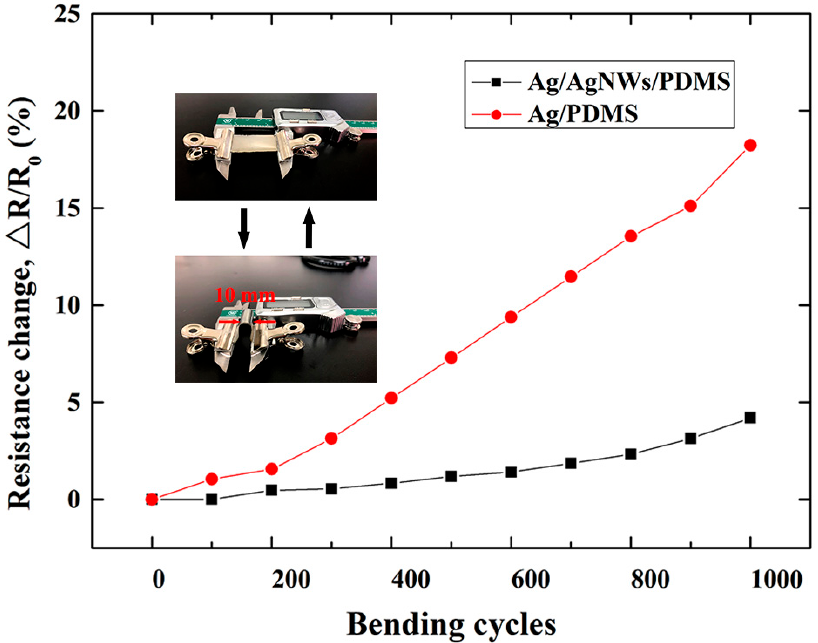
Figure 4. Δ R / R 0 profiles of the Ag/PDMS sensor and Ag/AgNWs/PDMS strain sensor under repeated bending cycles with a bending radius of 0.5 bending cycles with a bending radius of 0.5 cm.